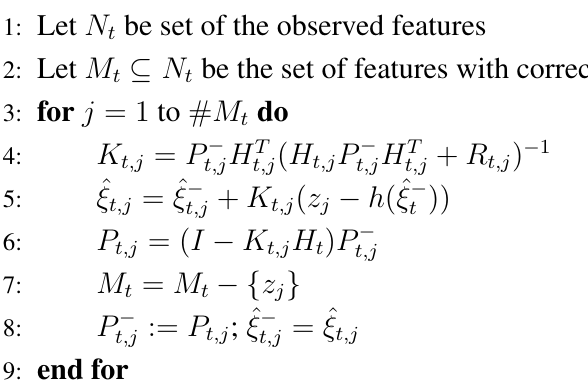
Algorithm 1. Algorithm of the Sequential